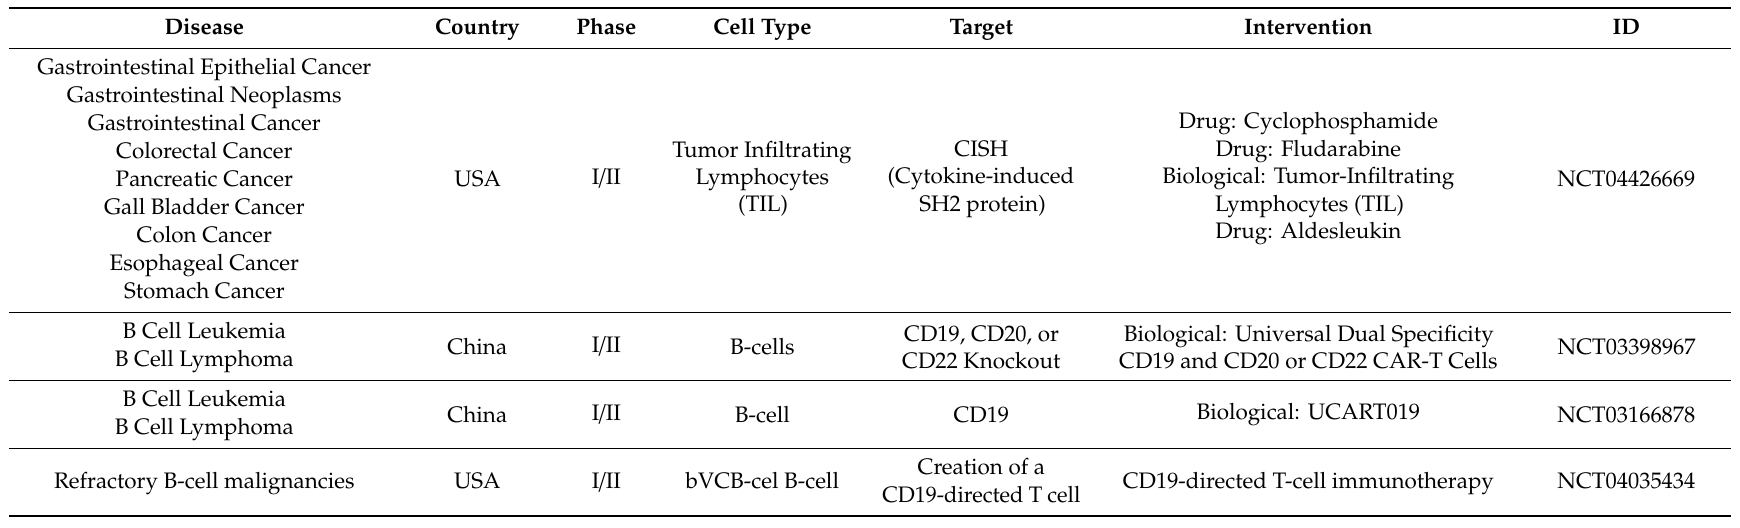
Table 1. The ongoing clinical trials of immunotherapeutic agents that include a CRISPR / Cas9 element, as found in